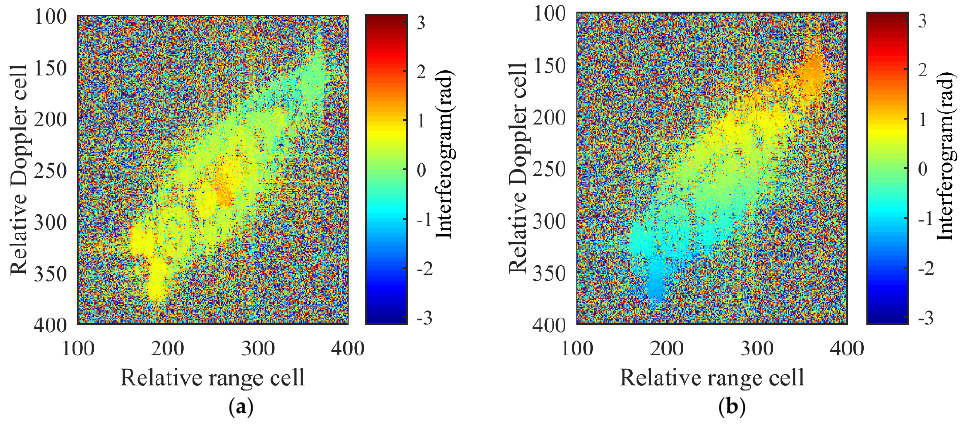
Figure 14. Interferograms. ( a ) AC–AV. ( b ) AC–AH.